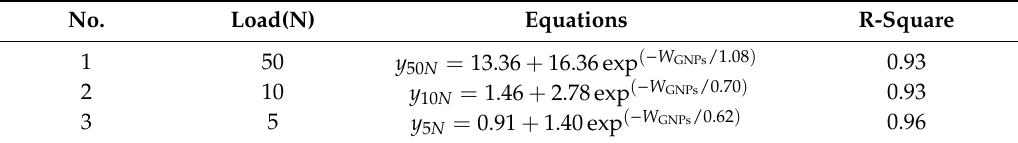
Figure 10. Variations of wear mass loss with varying GNPs content. Table 6. Regression equations of the mass loss versus WGNPs.